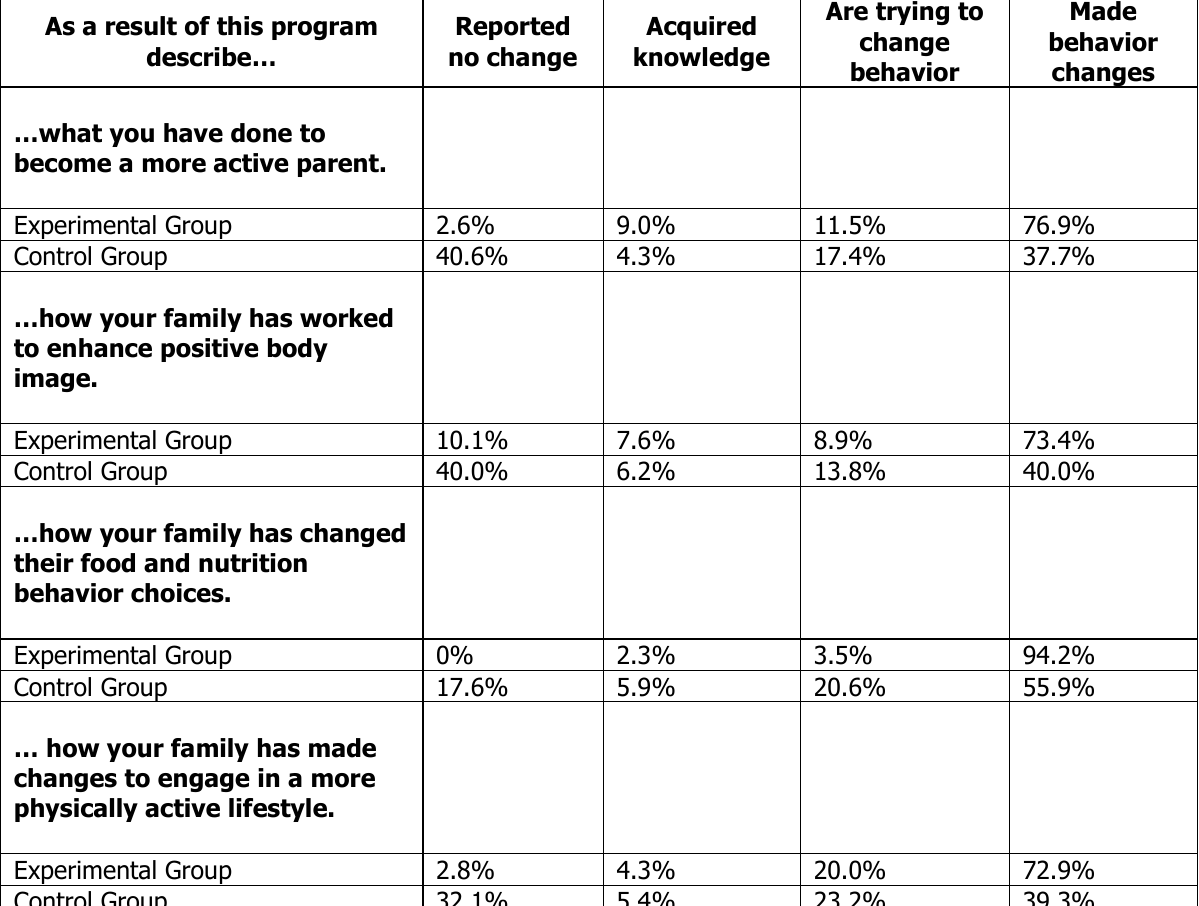
Percentage of responses from participants in the experimental and control